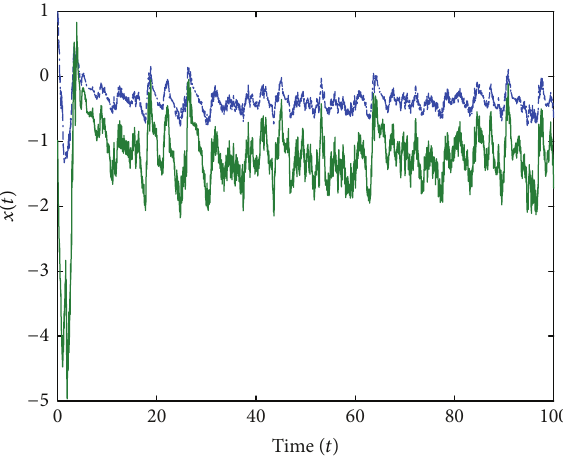
Figure 1: The solution of system (47) without impulses (single sample).